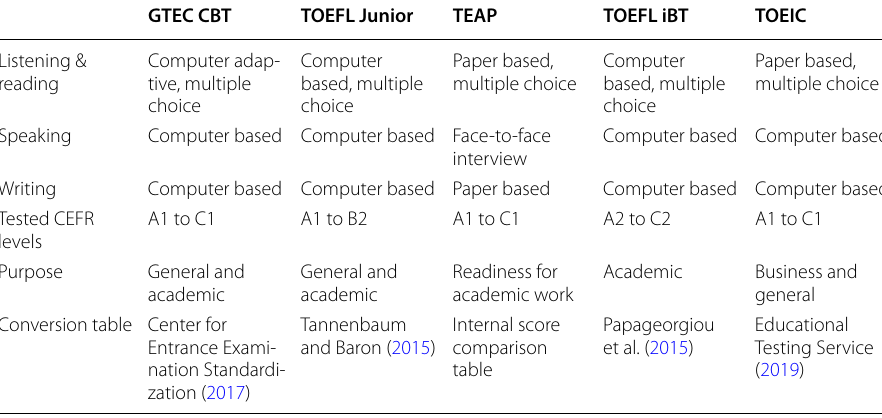
Table 2 Five tests used in Study